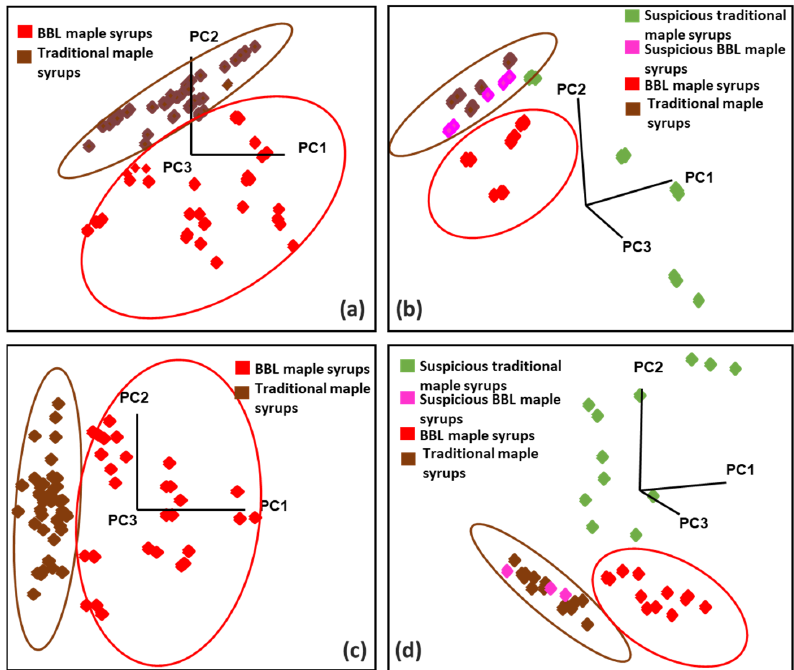
Figure 4. Soft independent modeling of class analogy (SIMCA) projection plots of classification of traditional and BBL maple syrups with ( a ) FT ‐ IR and ( c ) Raman; prediction of external validation sets, including authentic traditional and BBL samples and suspicious samples by ( b ) FT ‐ IR and ( d )